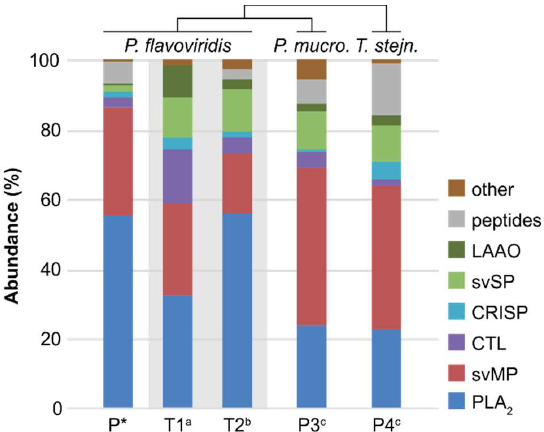
Figure 4. Venomic data of P. flavoviridis in comparison to the closed related P. mucrosquamatus and T. stejnegeri . Venom compositions of three proteomic pit viper analyses (P; quantified at 214 and 215 nm) and two venom gland transcriptomic analyses of P. flavoviridis (T1 and T2) in fragments per kilobase million (FPKM %). The asterisked data set P is the result of this study. “Other” represents, in all three P. flavoviridis data, phosphodiesterases, 5′-nucleotidases and components that were not annotated. Additionally, in the case of T1 and T2, galactose-binding lectins, nerve growth factors, phospholipases B, glutaminyl cyclases, vascular endothelial growth factor-like proteins, as well as less abundantly detected families, with <0.01%, are included. For P. mucrosquamatus (P3, P. mucro. ), “other” represents trimucrotoxin, and, for T. stejnegeri (P4, T. stejn. ), “other” represents snake venom vascular endothelial growth factors. The origins of toxin ratios are marked alphabetically: a [37], b [31], c and d [50]. The phylogentic relationship is based on [15,51].